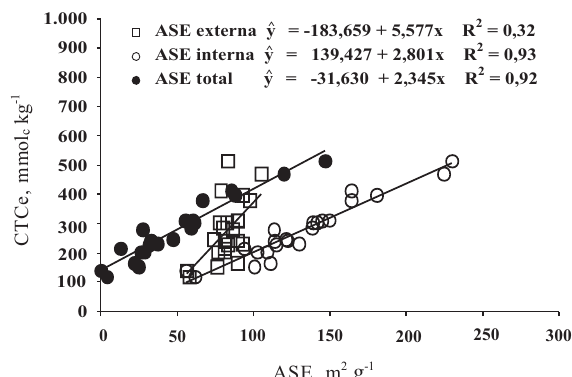
Figura 2. Relações entre os valores de área superficial específica (ASE) e a capacidade de troca catiônica efetiva (CTCe) da fração argila livre de matéria orgânica